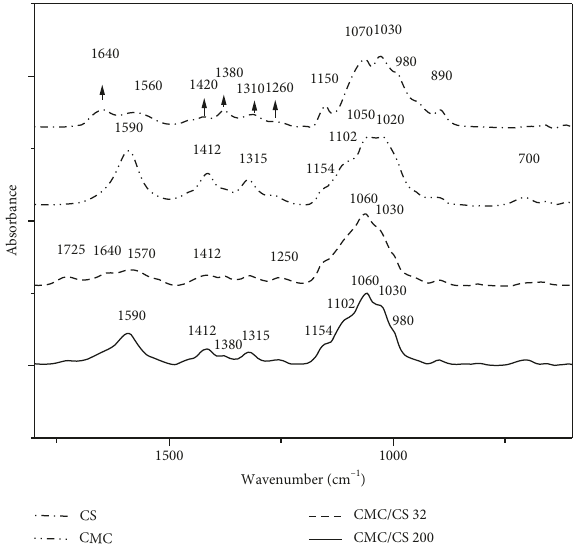
Figure 13: FTIR spectra from CS, CMC, CMC/CS ratio 32, and CMC/CS ratio 200.